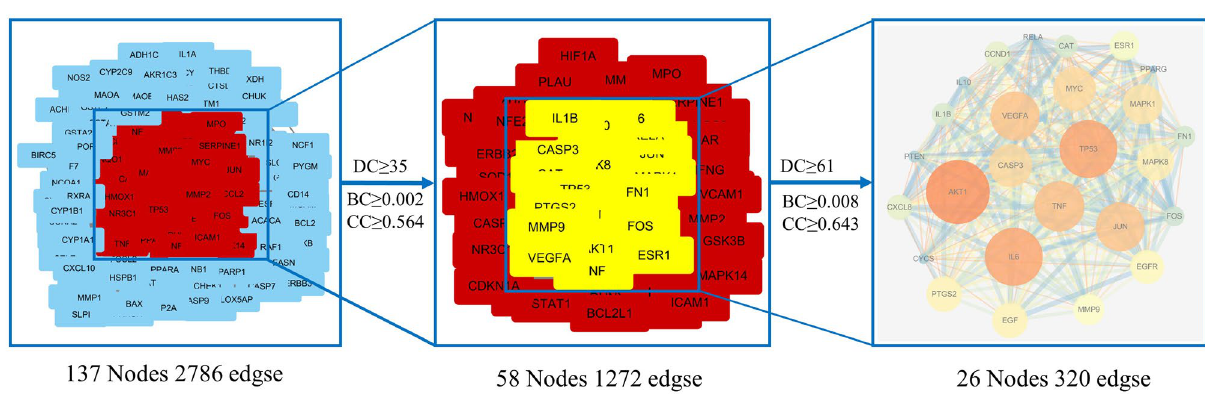
Figure 6. The whole screening process for the PPI network through a topological method. In the third image, the bigger size and brighter color represent higher DC